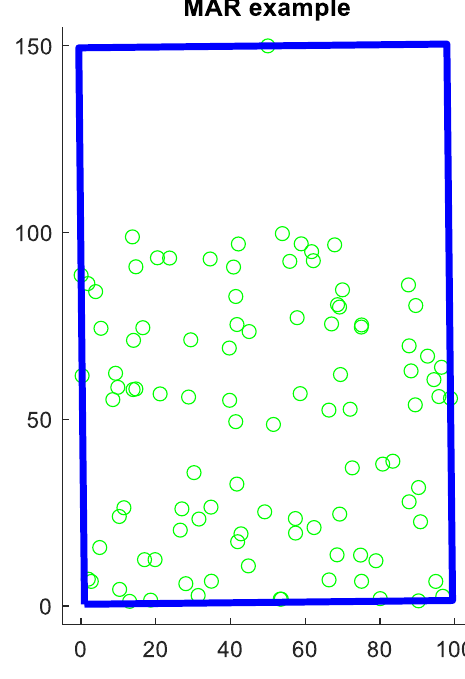
Figure 2. MAR example.